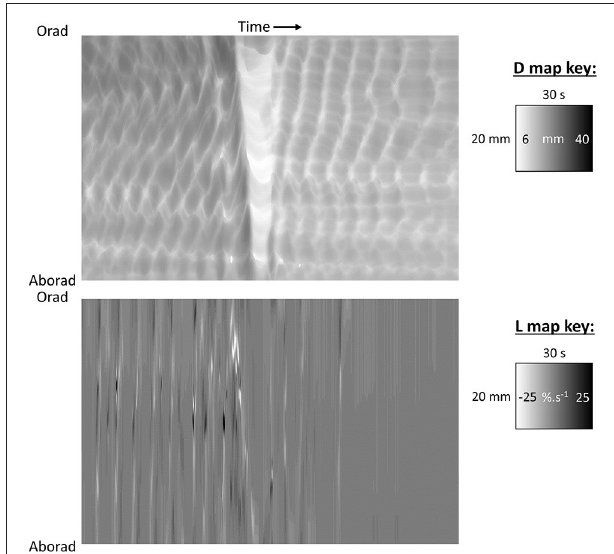
FIGURE 3 | D-type ST map (Top) and L-type ST maps (Bottom) of a mass peristaltic event traversing the proximal colon perfused with saline. The triangular white area on the D-map indicates a diametric constriction from mass peristalsis rapidly propagating from proximal to distal along the organ with a darker area from distension of the lumen by distally displaced contents traveling in advance. Note that the constriction propagates from proximal to distal but relaxation progresses from distal to proximal as can be seen by the differences in the slopes of the onset and offset of the event and the consequent triangular configuration. The angled track of narrow white areas (-ve strain rate) on the L map (Bottom) indicate a sequence of short-lived longitudinal constrictions occurring in advance of the diametric constriction of peristalsis. Note that more regular and more rapidly and extensively propagating longitudinal constriction (likely fast phasic contractions) and column of episodic localized radial constriction (likely ripple contractions) occur at times when there are no peristalses. Figure adapted from Lentle et al.